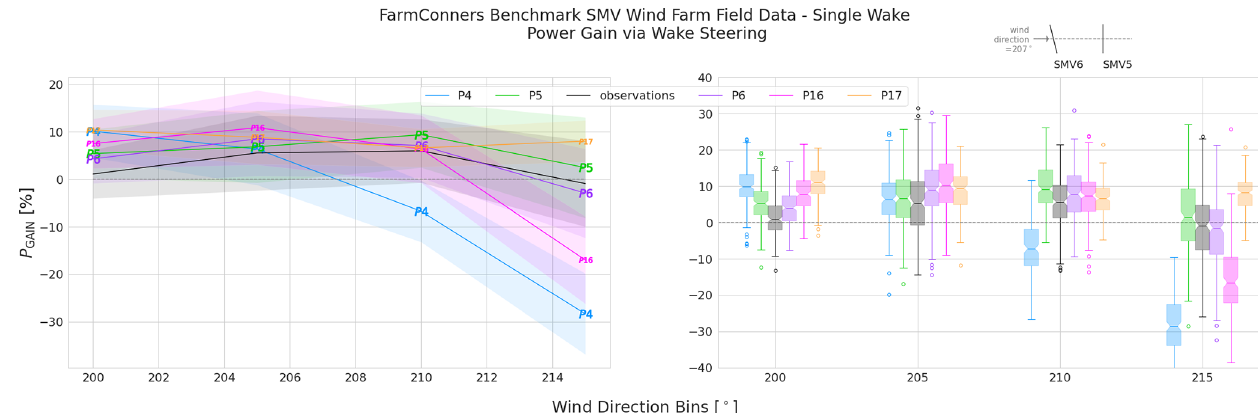
Figure 14. SMV WF field data, single wake under wake steering – power gain comparison under wake steering control with − 13.3 ◦ upstream misalignment. Representative layout with corresponding yaw control setting is illustrated at the upper right